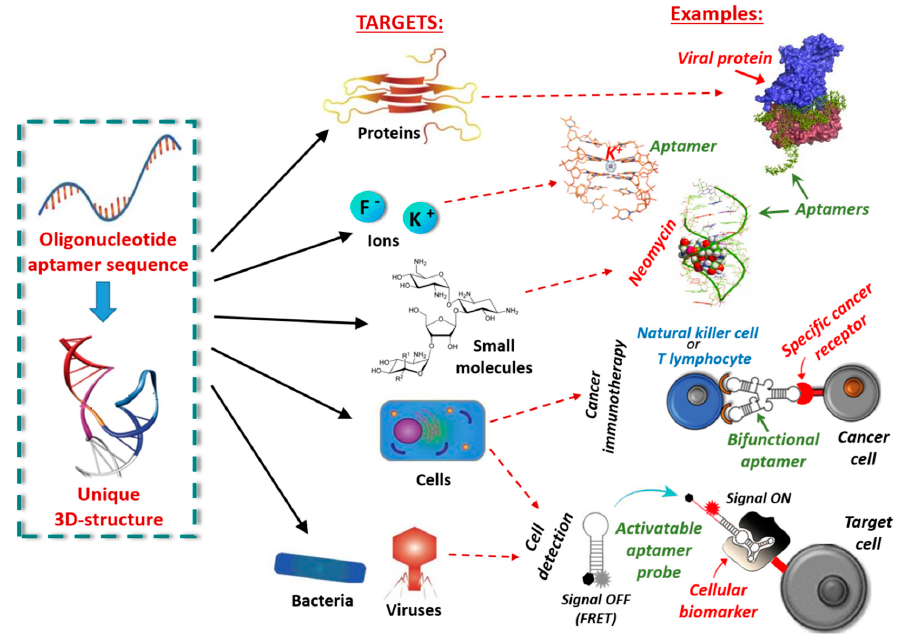
Figure 1. Schematic representation of possible targets of oligonucleotide aptamers and corresponding